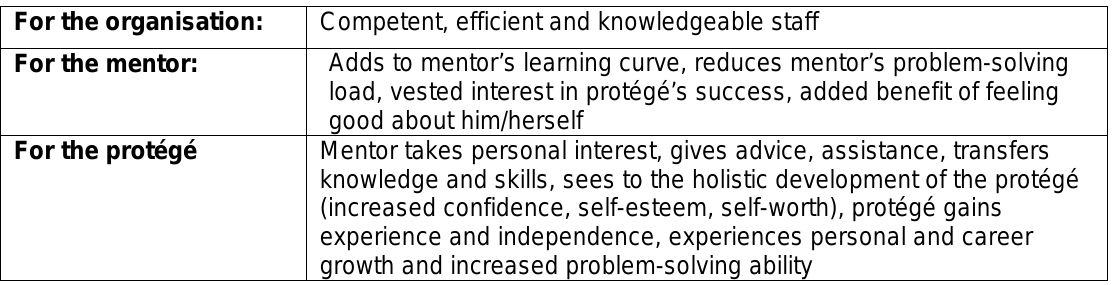
Table 3. Aspects related to the benefits of mentorship For the